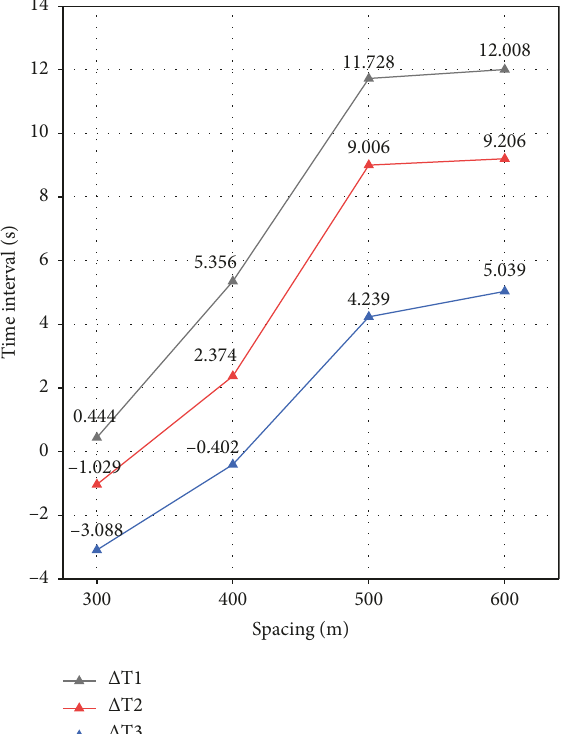
Figure 7: The average time interval of lane-changing feature points of different spacings. Δ T interval of starting point to upper starting point, crossing point to upper starting point, and ending point to the upper starting point. 0.000.250.500.751.00